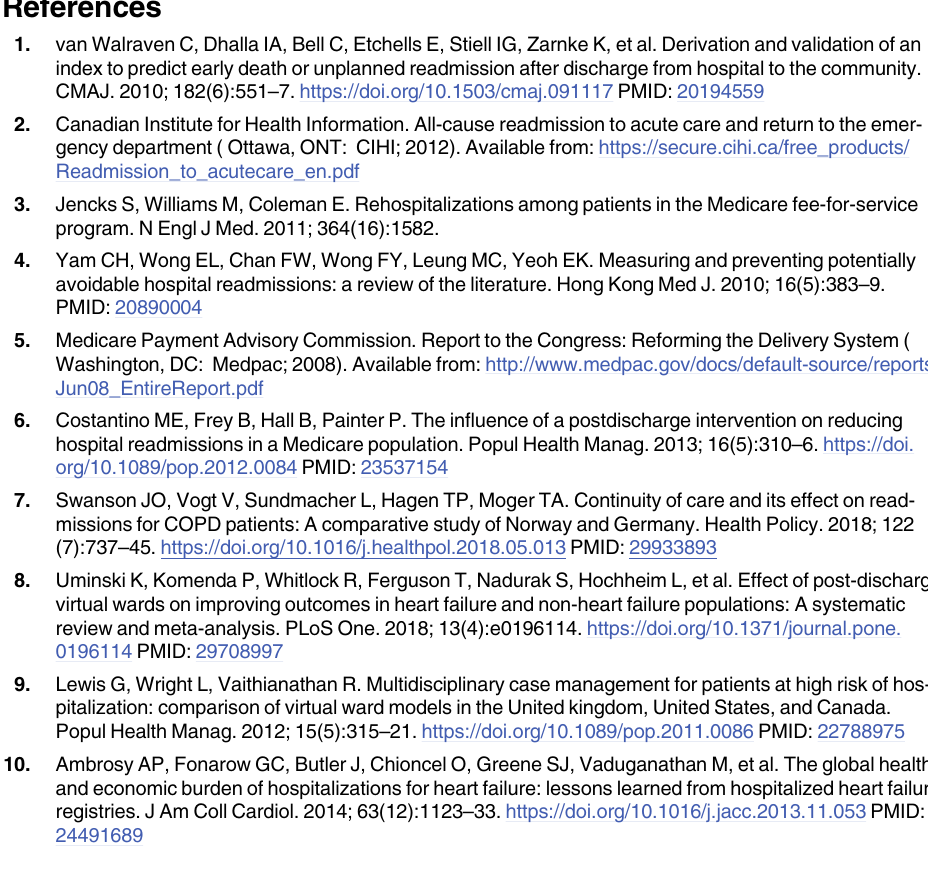
S4 Table. Individual risk of bias assessment for all included studies using the Cochrane Collaboration’s Tool for randomized